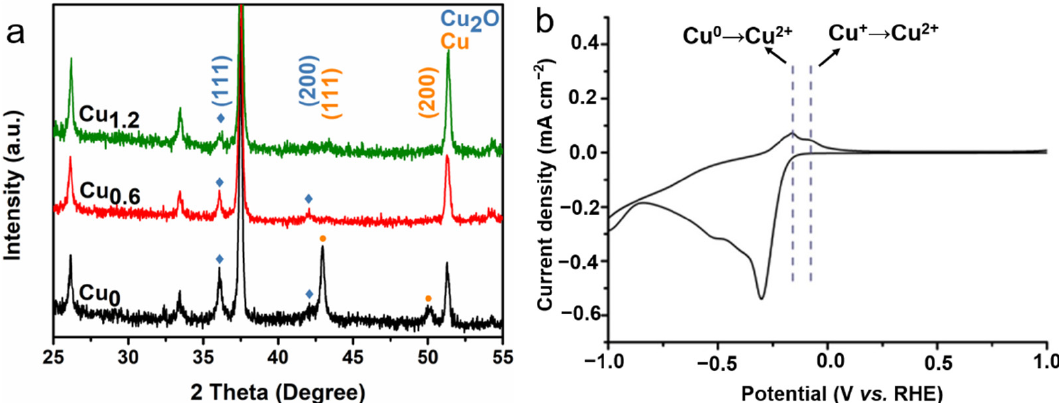
Figure 6. XRD patterns of the copper-based electrodes; unmarked peaks for FTO ( a ). CV for Cu 0.6 as the anode ( b ).